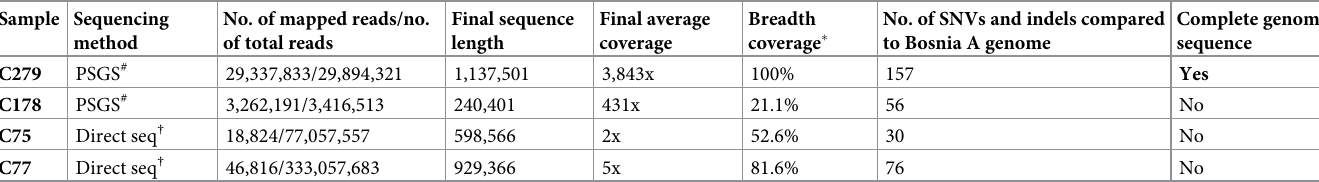
Table 2. Sequencing results of four samples containing TEN isolated from Cuban patients. Sample Sequencing method